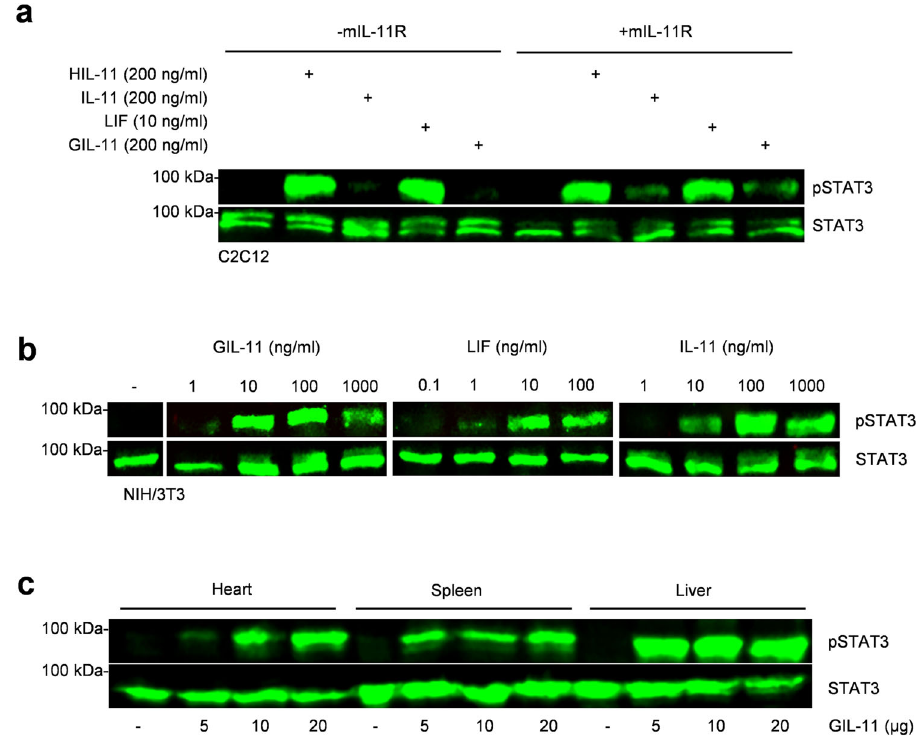
Fig. 6 Human GIL-11 transmits signal transduction via the non-natural murine gp130:IL-11R:LIFR cytokine receptor complex. a STAT3 activation in un- transfected and transfected with a cDNA coding for murine IL-11R murine myoblasts (C2C12) without cytokine (-) and after stimulation with HIL-11 (200 ng/ml), IL-11 (200 ng/ml), LIF (10 ng/ml), GIL-11 (200 ng/ml) for 15 min. Equal amounts of proteins (50 µ g/lane) were analyzed via speci fi c antibodies detecting phospho-STAT3 and STAT3. Western blot data shows one representative experiment out of three. b STAT3 activation in murine fi broblast NIH/3T3 without cytokine (-) and after stimulation with increasing amounts of GIL-11 (1, 10, 100, 1000ng/ml), LIF (0.1, 1, 10, 100 ng/ml) and IL- 11 (1, 10, 100, 1000 ng/ml) for 20 min. Equal amounts of proteins (50 µ g/lane) were analyzed via speci fi c antibodies detecting phospho-STAT3 and STAT3. Western blot data shows one representative experiment out of three. c STAT3 activation in heart, liver and spleen after injection of 5, 10 or 20 µ g/ ml GIL-11. Mice were sacri fi ced 30 min after intraperitoneal cytokine injection. Equal amounts of proteins (50 µ g/lane) were analyzed via speci fi c antibodies detecting phospho-STAT3 and STAT3. Western blot data shows one representative experiment out of